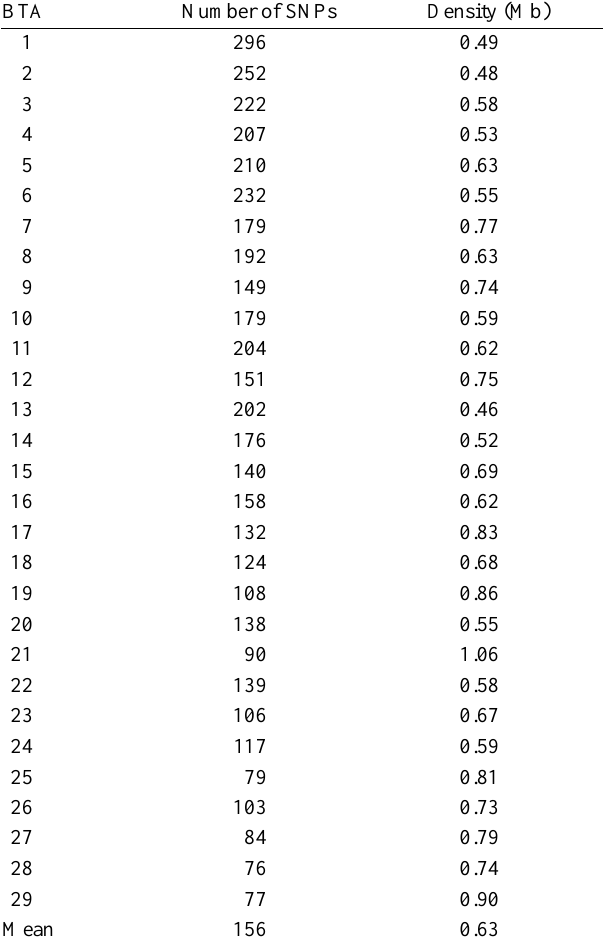
Table 2. Summary for distribution of SNPs and density on